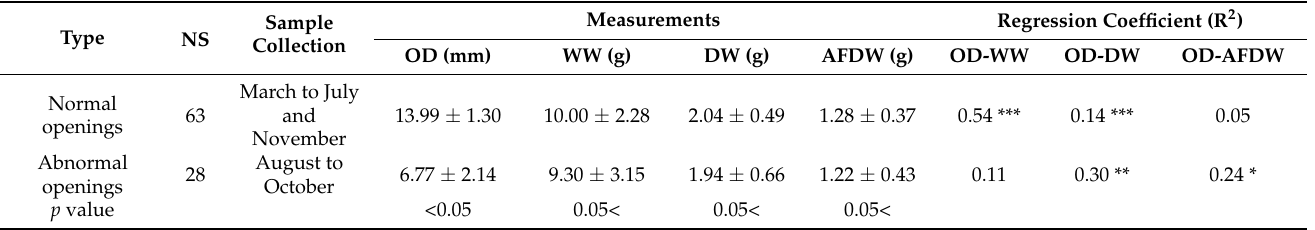
Table 4. Comparison of morphometric data (mean value ± standard deviation) and regression coefficient (R 2 ) between normal and abnormal openings for U. major (* p < 0.05, ** p < 0.01, *** p < 0.001). Significant differences by t -test at 0.05.